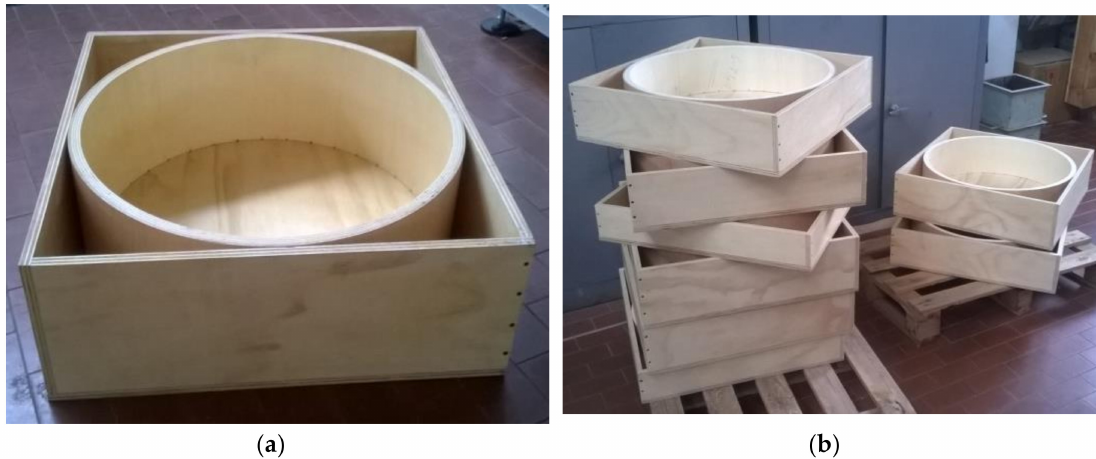
Figure 4. Containment boxes for laboratory samples of growing media. ( a ) detail of the inner containment ring with drainage holes, ( b ) set of boxes of different thicknesses (80, 120, 140 and 180